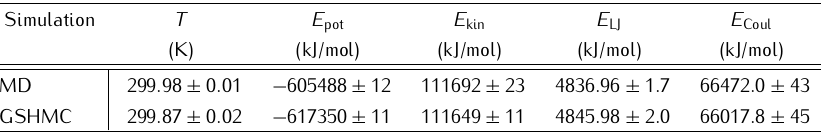
Table 2. Equilibrium averages ± standard deviations of